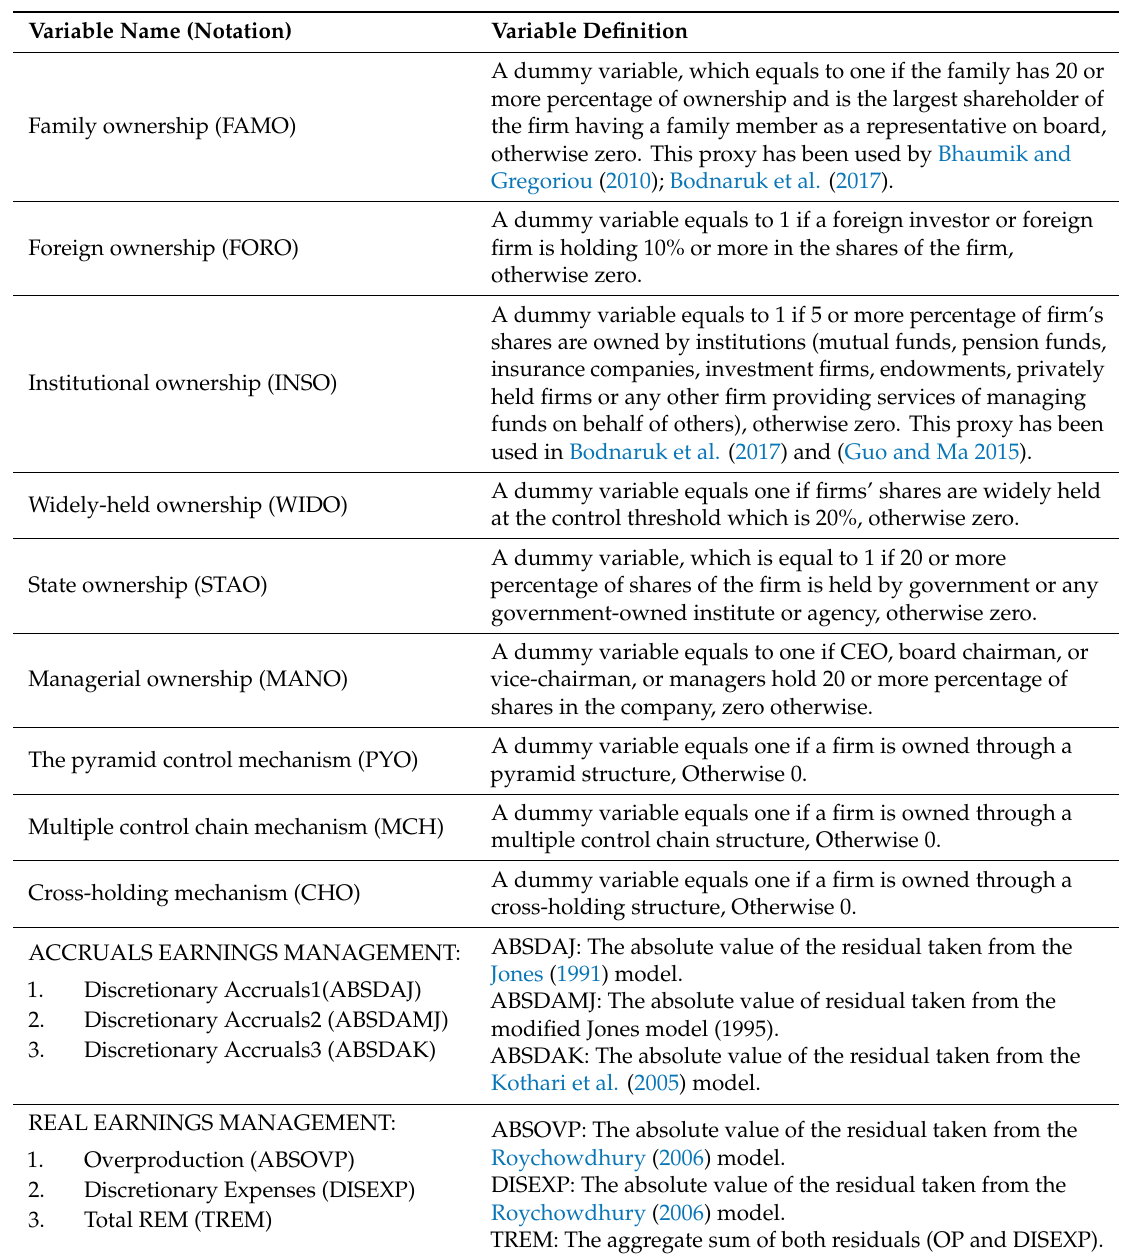
Table A1. Variable